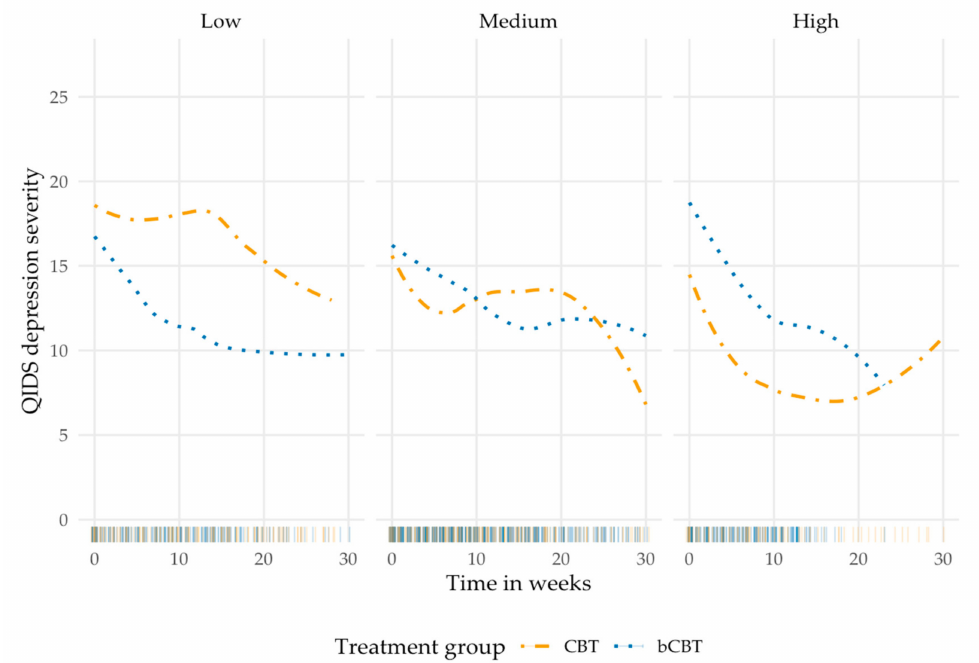
Figure 1. Observed change in depression over time for both treatment groups, clustered in low, medium, and high patient-rated working alliance (measured at week 10). bCBT: blended Cognitive Behavioral Therapy; CBT: Cognitive Behavioral Therapy (face-to-face only); QIDS: Quick Inventory of Depressive Symptomatology.